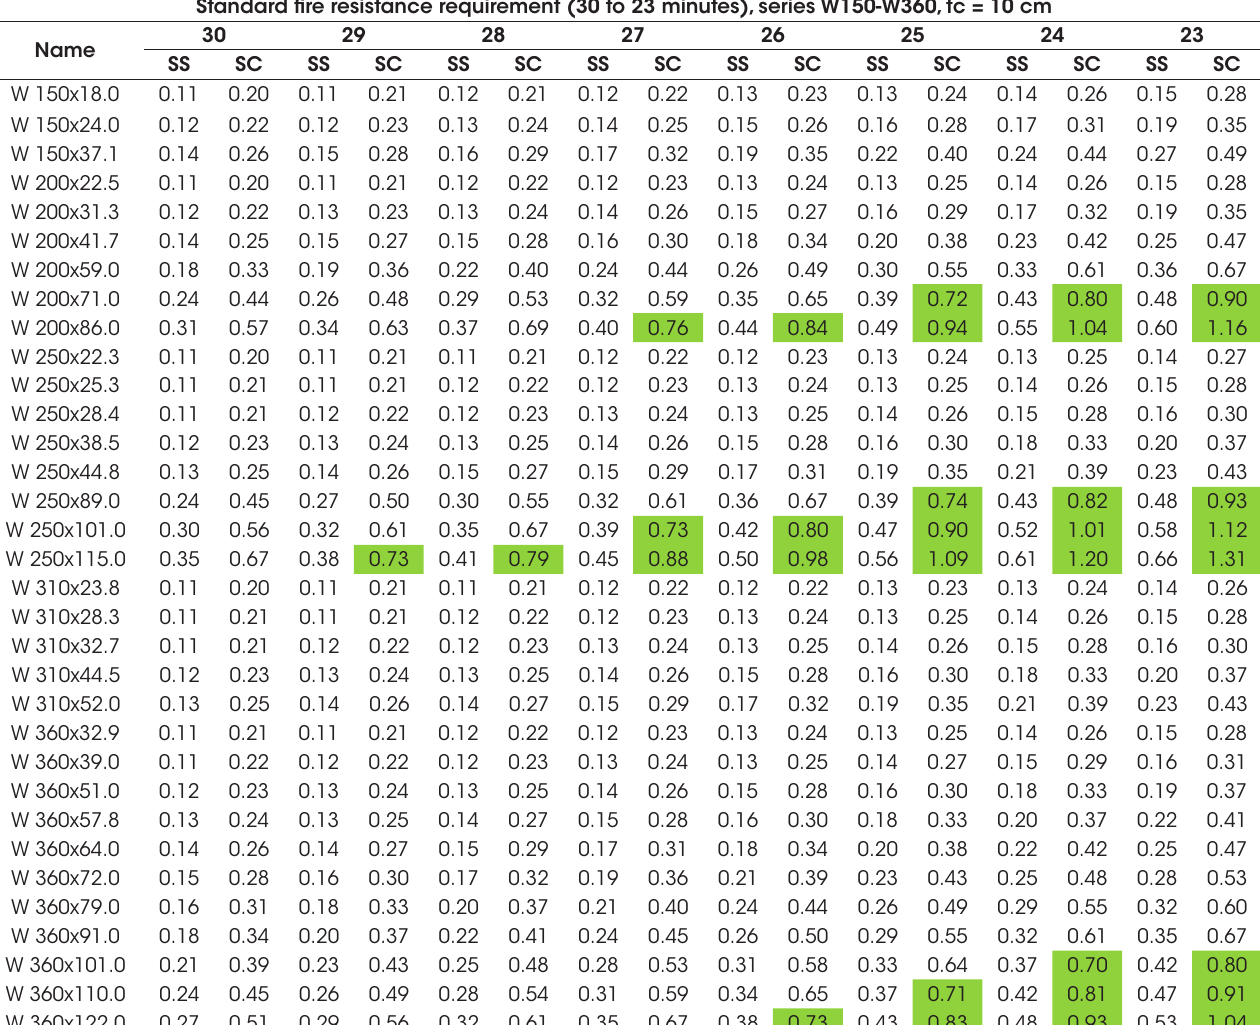
Load factors as function of the standard fire resistance requirement for composite beams with 10 cm slab and Gerdau profile series